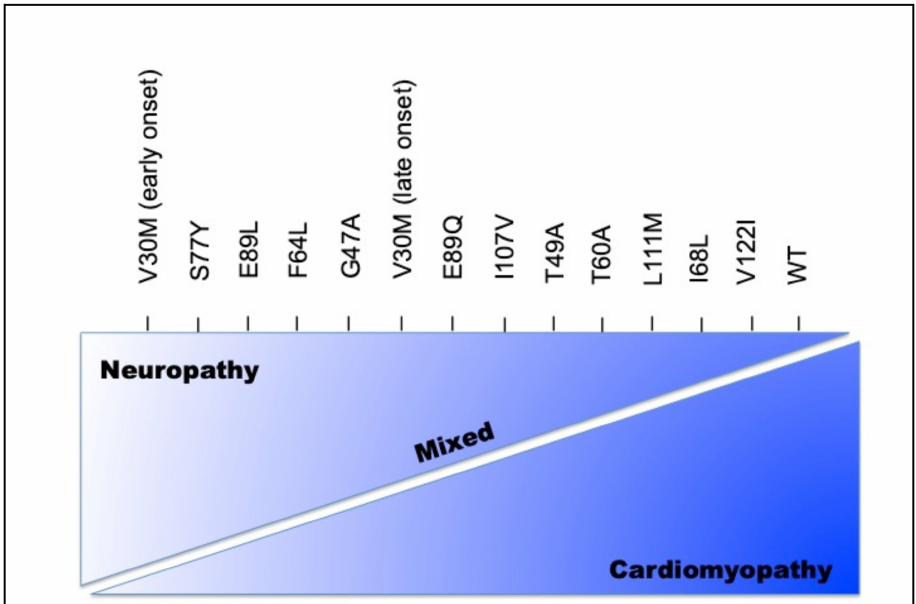
Figure 2. Phenotypic heterogeneity according to genotype. Modified from: Rapezzi C, Quarta CC et al. Disease profile and differential diagnosis of hereditary transthyretin-related amyloidosis with exclusively cardiac phenotype: an Italian perspective